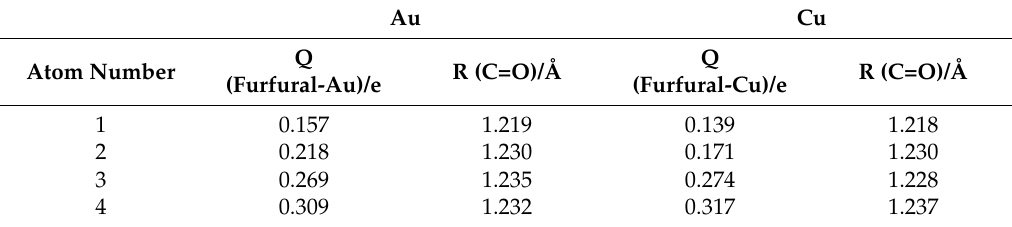
Table 3. The charge transfer and bond length (C=O) of furfural-M x (M = Au, Cu). Au Cu Q Atom Number